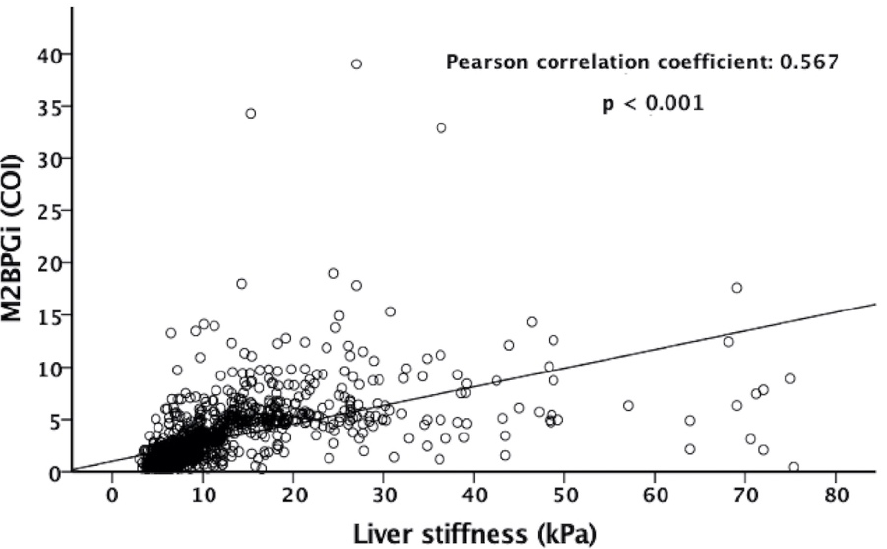
Figure 2. Scatter plot of serum M2BPGi level (COI) and LSM (kPa) with TE. The Pearson correlation efficient was 0.567 ( p < 0.001).